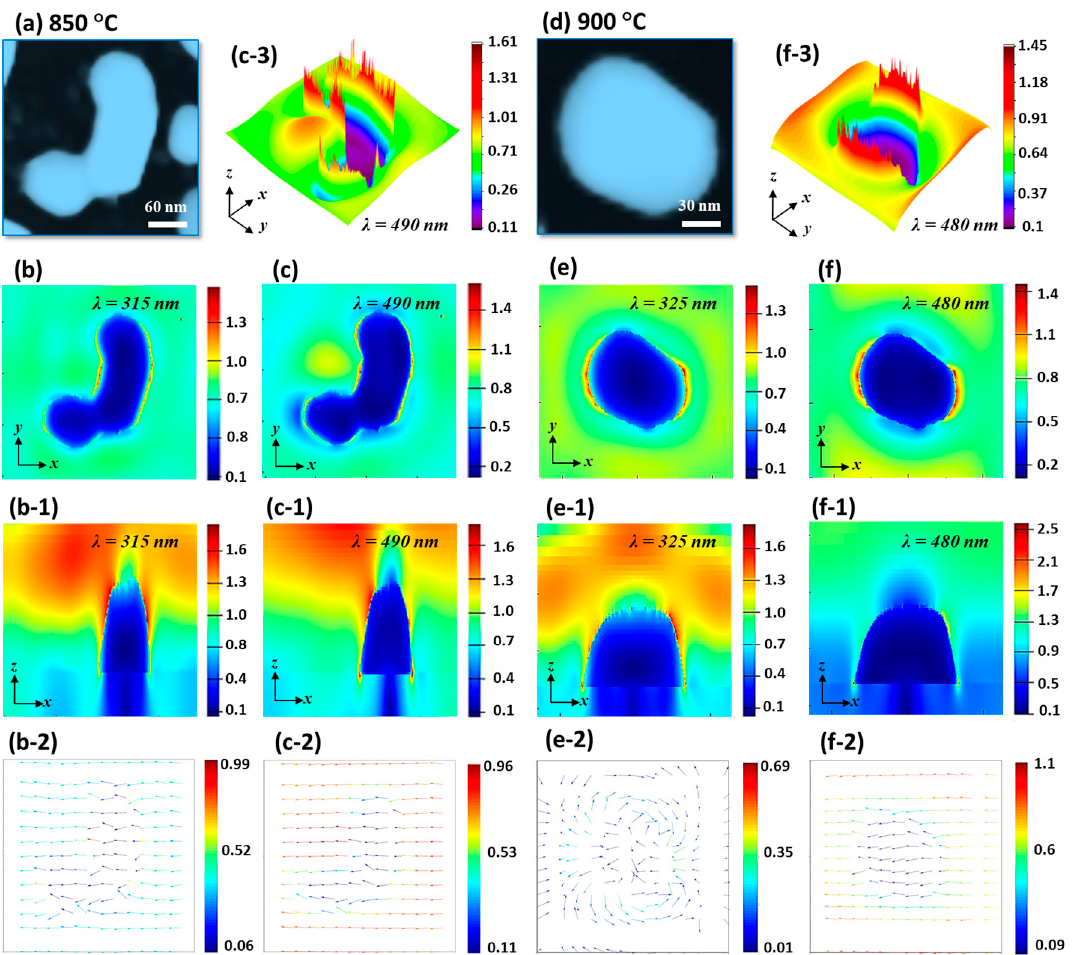
Figure 7. FDTD analysis of the medium size Pt NPs on sapphire fabricated with the In 45 nm / Pt 15 nm bilayers. ( a ) and ( d ) AFM image of the Pt NPs at 850 and 900 ◦ C. ( b )–( c ) and ( e )–( f ) E-field profiles of Pt NPs in xy-plane. ( b-1 )–( c-1 ) and ( e-1 )–( f-1 ) E-field profiles in xz-plane. ( b-2 )–( c-2 ) and ( e-2 )–( f-2 ) e-field vector plots. ( c-3 ) and ( f-3 ) 3D view of the e-field profiles at specific wavelength.